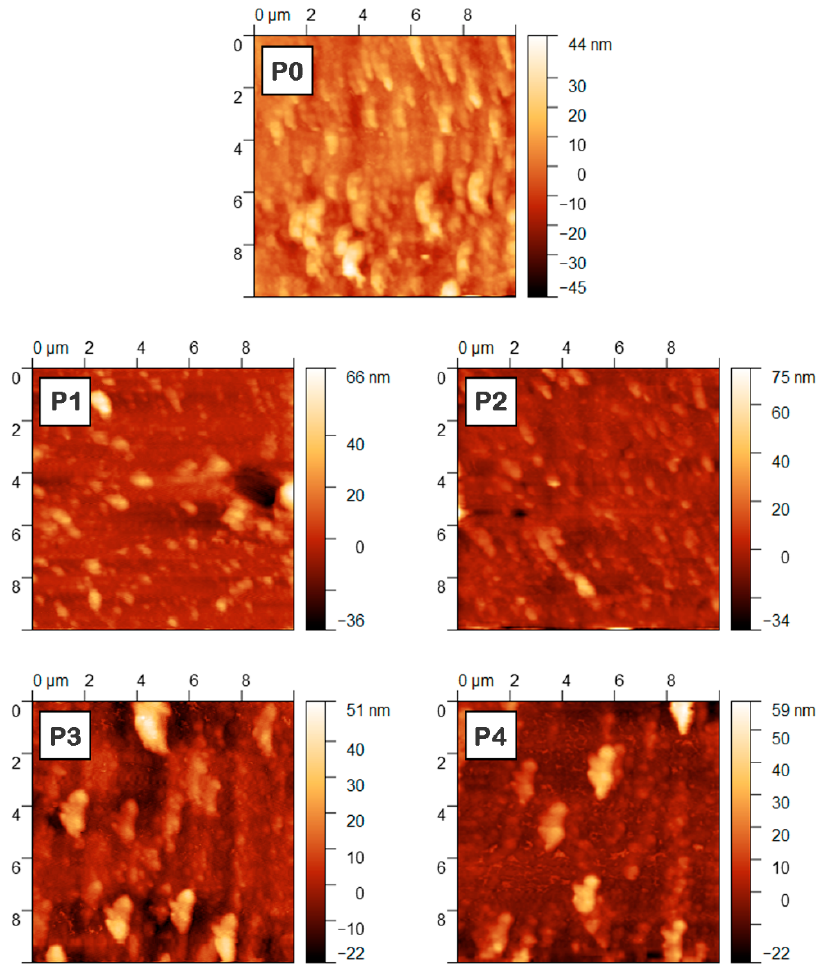
Figure 6. AFM images of the P0–P4 films deposited by MAPLE on ITO/PEDOT:PSS (10 μ m × 10 μ m).